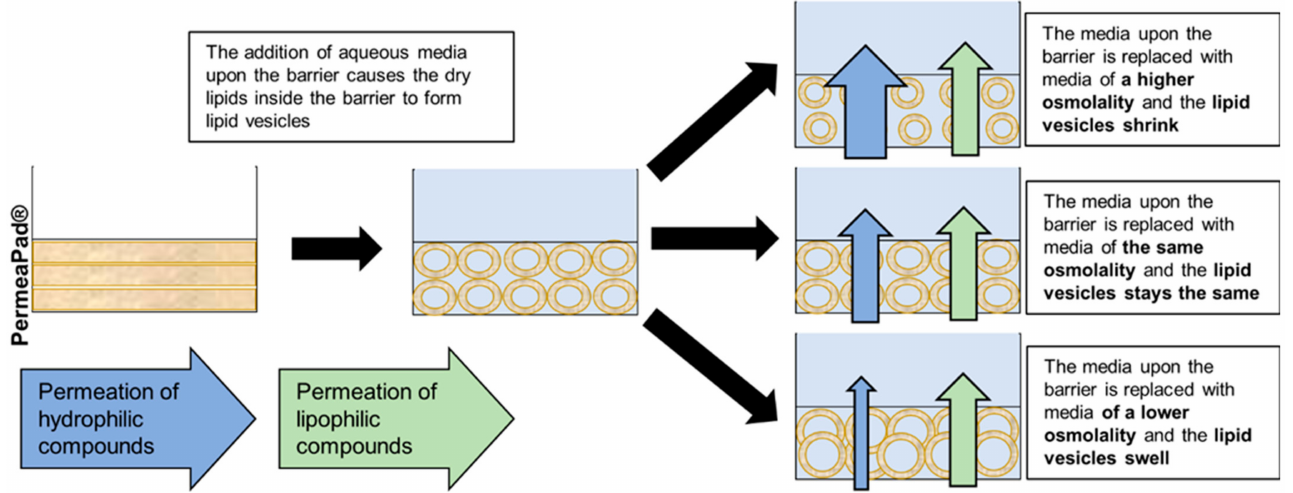
Figure 2. Schematic illustration of lipid vesicles shrinking due to the pretreatment of PermeaPad ® with a hypo-osmotic